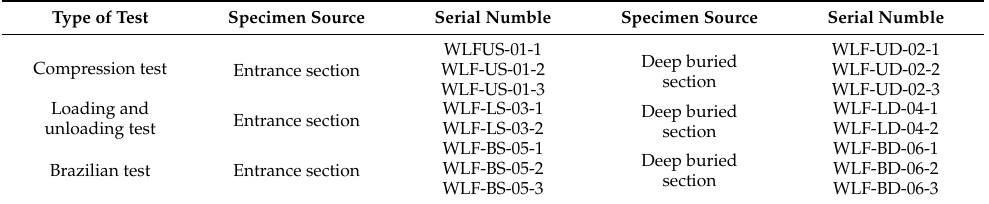
Table 2. Number of rock mechanics test samples.